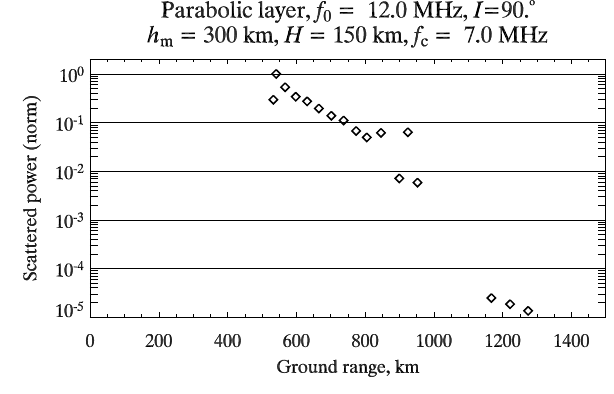
Fig. 2. Effective scatter volume locations for each range gate (dia- monds) obtained through power-weighted averaging of the simula- tion data from Fig. 1. Yellow contour corresponds to aspect condi- tion ( 8).